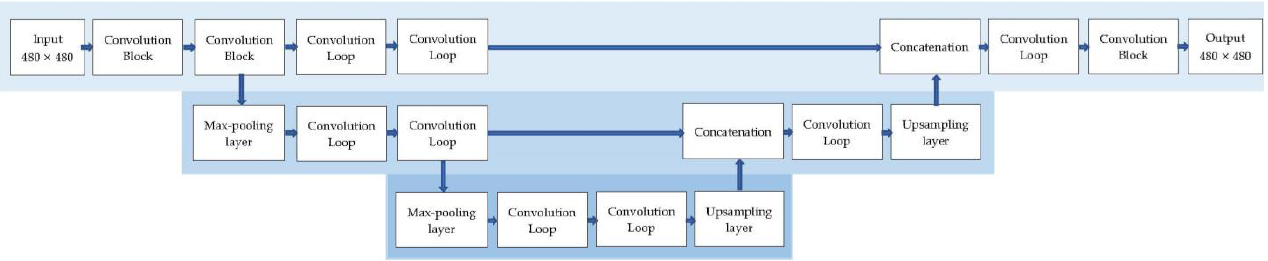
Figure 5. LoopNet network